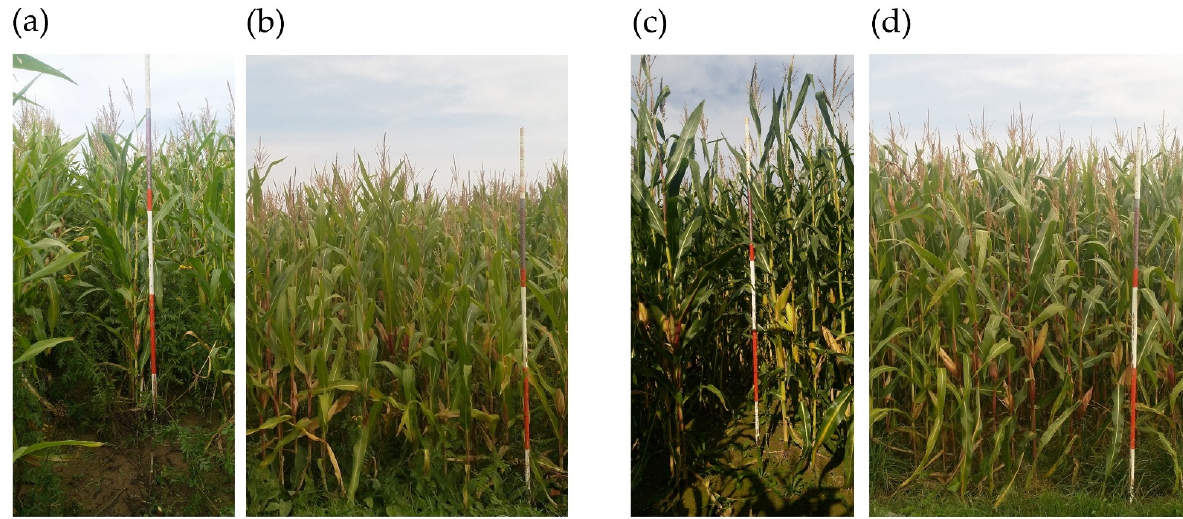
Figure 4. An impression of the maize plant stand within the treatment area “after wild plant cultivation”, two days after the mechanical weeding was carried out (21 June 2021). While most of the common tansy plants and the other non-target species between the maize rows were destroyed, had previously been only grassland (Figure 5). a few common tansy individuals survived (red arrows).